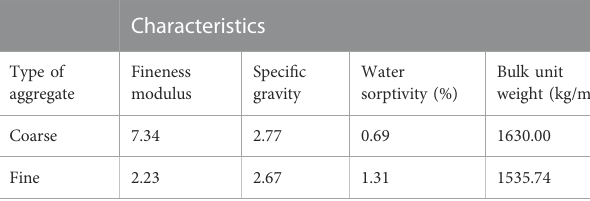
TABLE 1 Chemical characteristics of